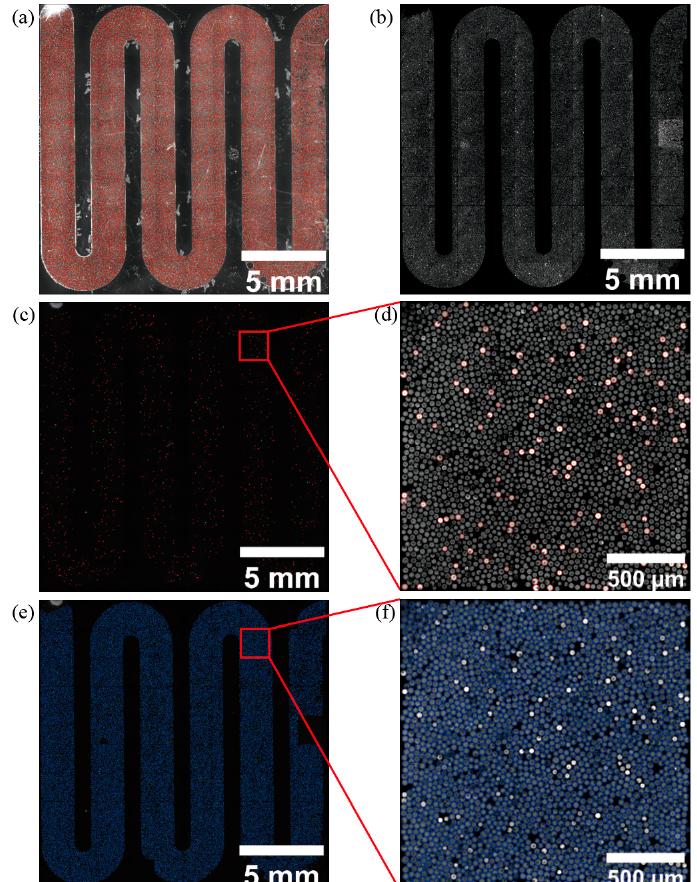
Figure 5. Plots of classification results for positive and negative droplets. ( a ) The result of droplet localization for bright-field images. ( b ) The resulting map of the bright-field image localization information in the fluorescence channel image segmented droplets. ( c ) The resulting map of positive droplets was identified and classified. ( d ) The resulting map of positive droplets (red circles) is identified from a fluorescence image in ( c ). ( e ) The resulting map of negative droplets was identified and classified. ( f ) The result of identifying negative droplets (blue circles) of a fluorescent image in ( e ).